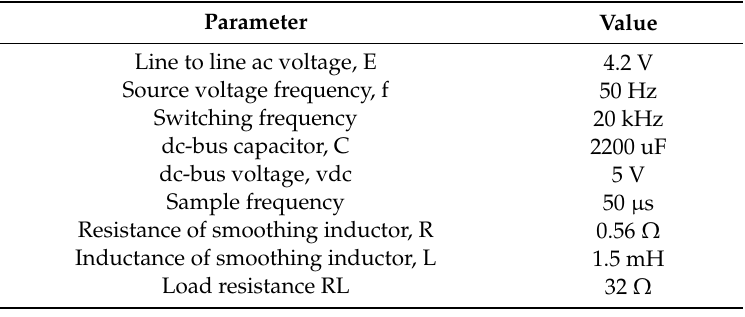
Table 3. Electrical parameters power circuit.